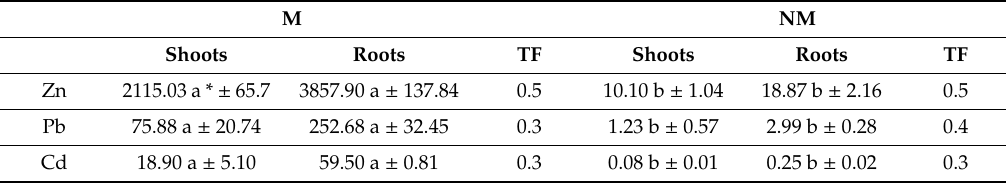
Table 1. Content of Zn, Pb and Cd in kidney vetch shoots and roots (mg · kg − 1 DW) from calamine (M) wastes and control (NM)